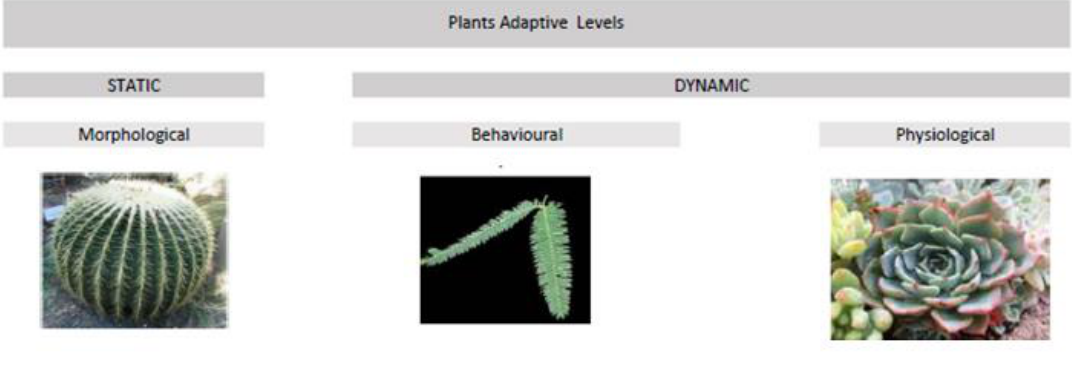
Figure 4 : An example to Plant's adaptive